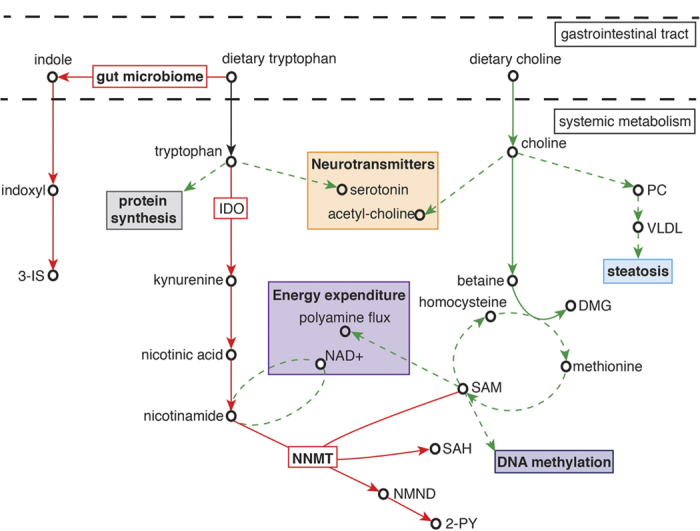
Metabolic pathways modulated by undernutrition.Red solid arrows indicate pathways increased with undernutrition (negatively associated with HAZ, WAZ, WHZ) and green solid arrows indicate pathways decreased with undernutrition (positively associated with HAZ, WAZ, WHZ). Dashed green arrows indicate pathways and biological functions hypothesized to decrease as a result of these metabolic alterations. 3-IS, 3-indoxyl-sulfate; DMG, dimethylglycine; IDO, indoleamine 2,3-dioxygenase; NAD, nicotinamide adenine dinucleotide; NMND, N-methylnicotinamide; NNMT, nicotinamide N-methyltransferase; PC, phosphatidylcholine; SAH, S-adenosyl-L-homocysteine; SAMe, S-adenosyl-L-methionine; VLDL; very-low-density lipoproteins.